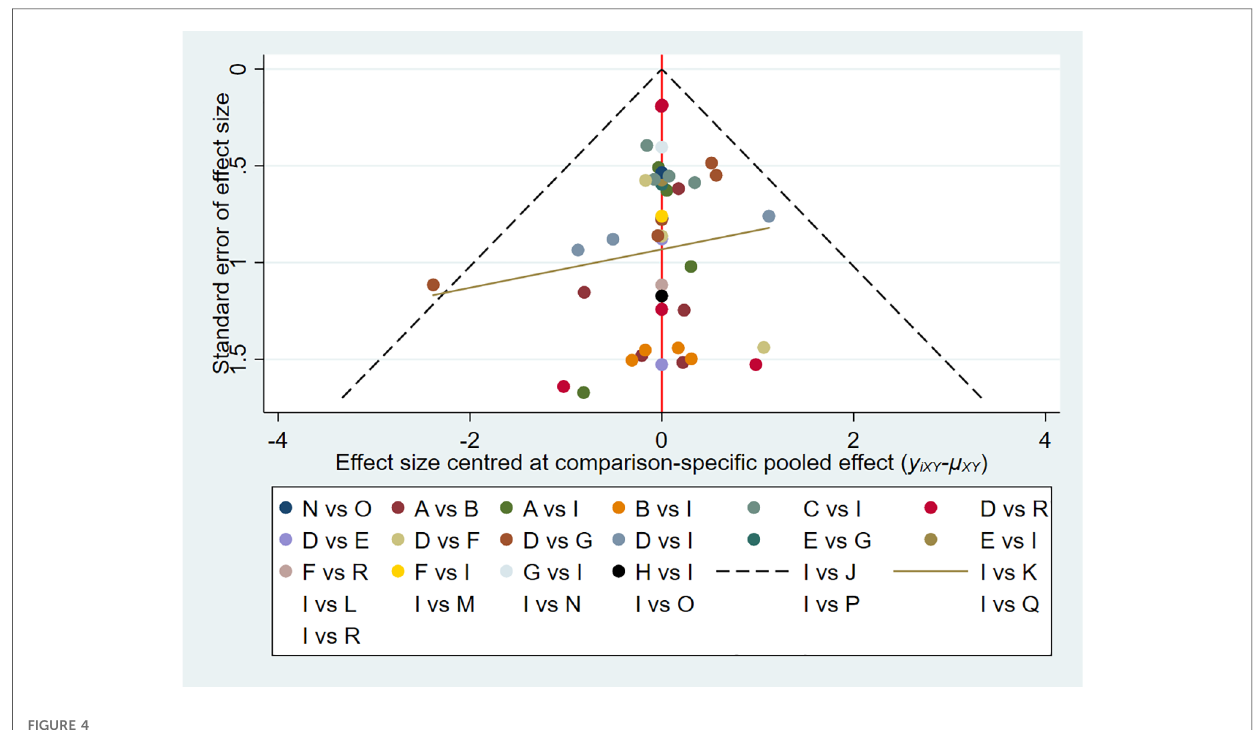
FIGURE 4 Funnel plot on publication